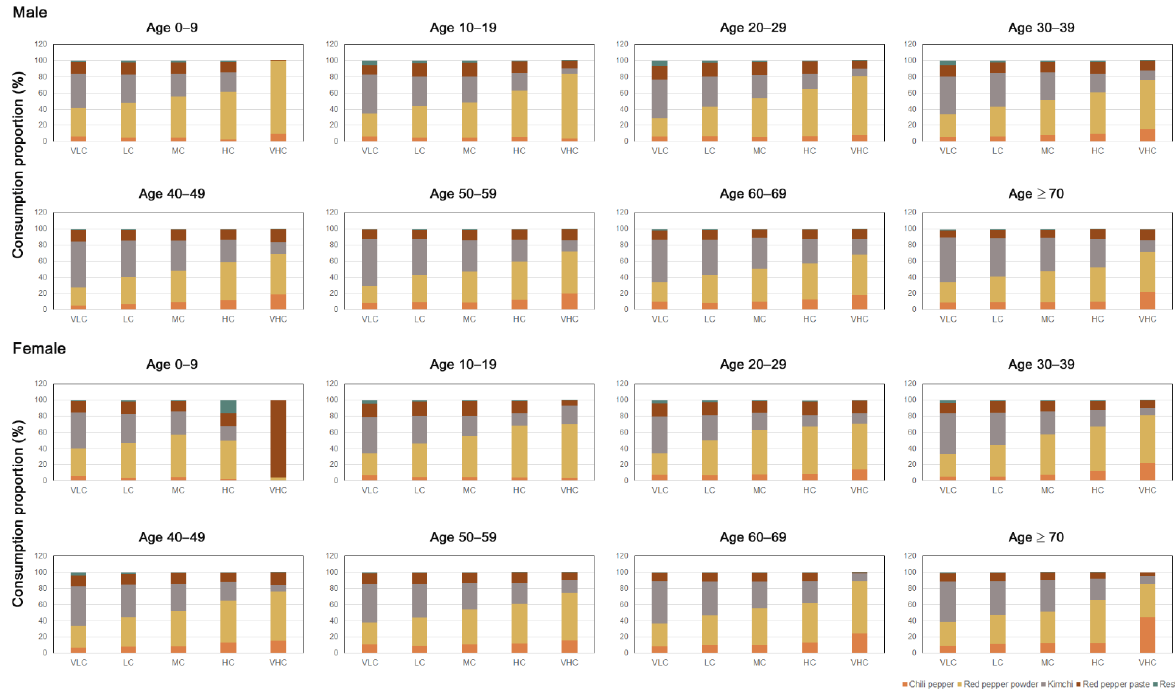
Figure 1. Consumption proportion of various capsaicinoid sources in the Korean diet in the five capsaicinoid intake subgroups in each age and sex group. The study participants were divided into five subgroups depending on the level of capsaicinoid intake: very low capsaicinoid (VLC), low capsaicinoid (LC), moderate capsaicinoid (MC), high capsaicinoid (HC), and very high capsaicinoid (VHC) intake.